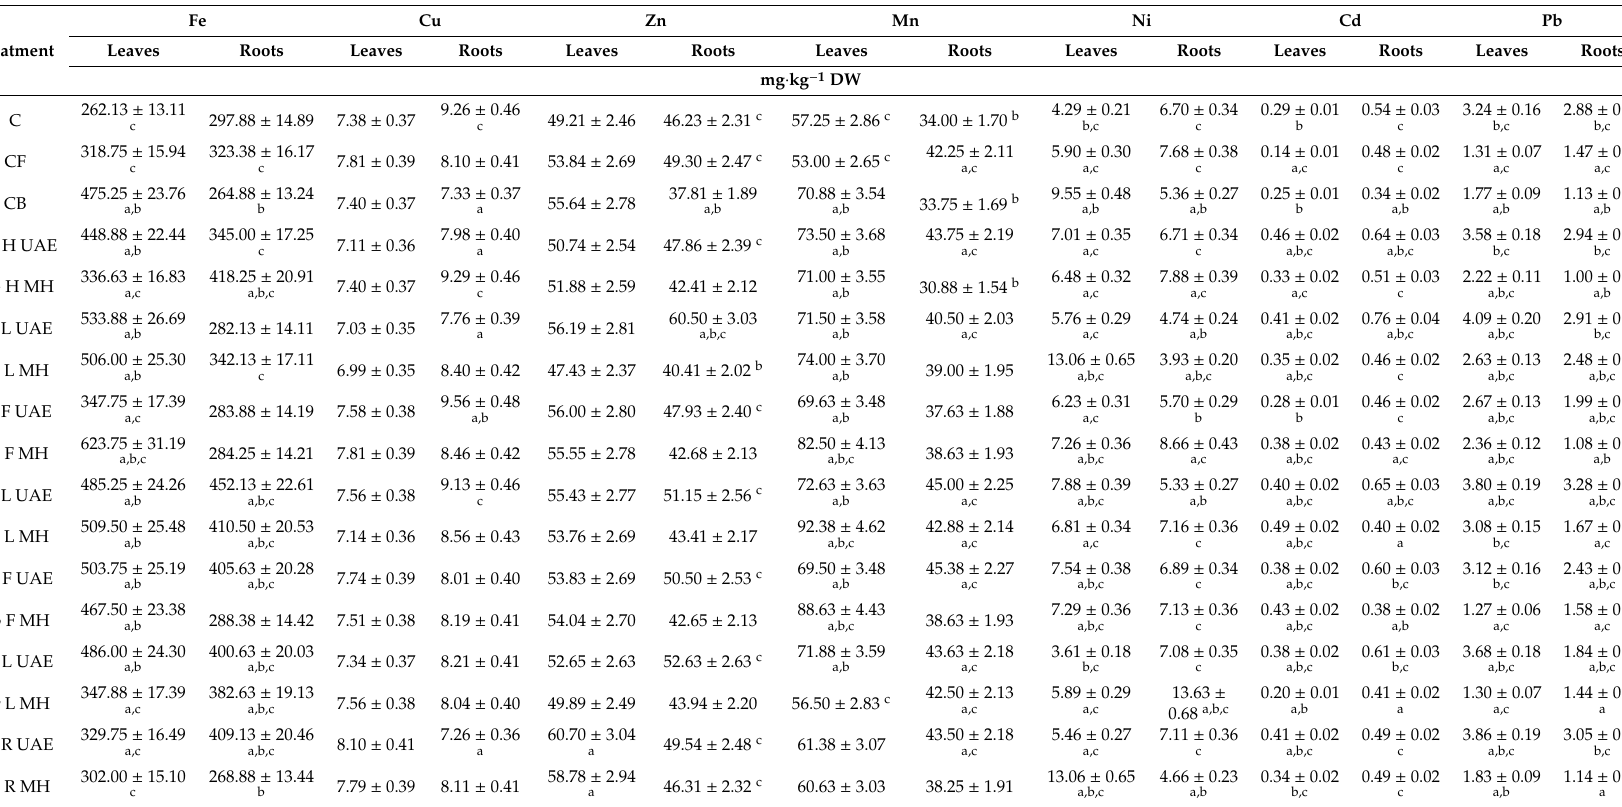
Table 4. E ff ect of the foliar application of botanical extracts on the microelements and toxic elements content of celeriac leaves and roots (N = 3, mean ± SD).